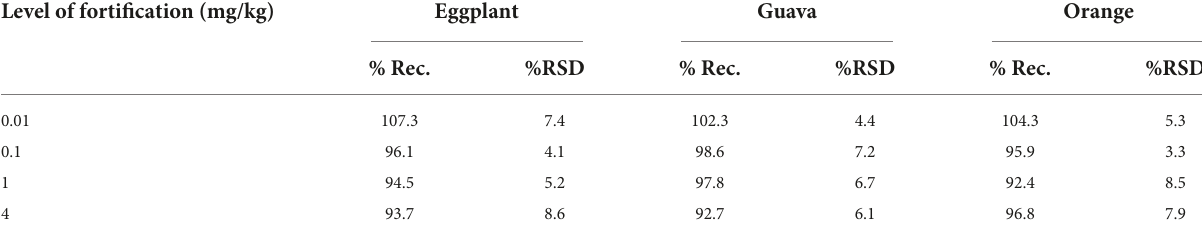
TABLE 3 Recovery of fenpyroximate in eggplant, guava, and orange samples ( n = 7). Level of fortification (mg/kg)